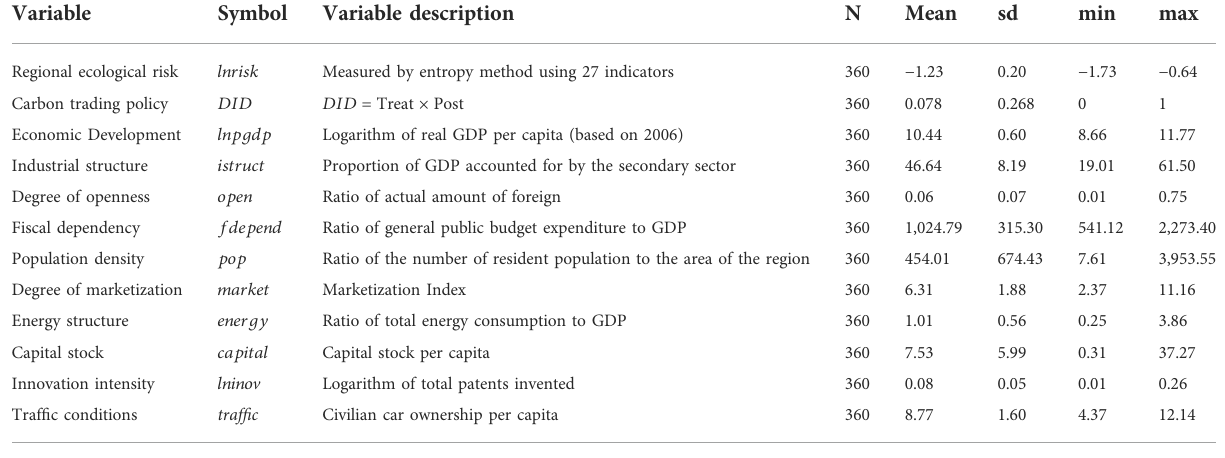
TABLE 2 Variable de fi nition and descriptive statistics.